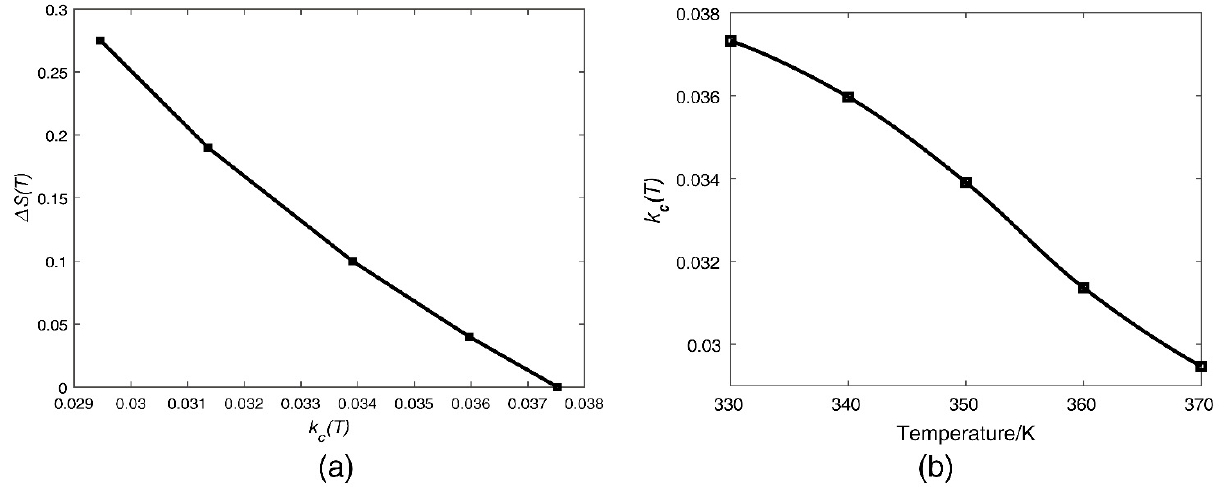
Figure 3. ( a ) The normalized drift of the parametric sensitivity in AR as with variation of coupling stiffness. Temperature ranges from 330 K to 370 K (these k c ( T ) data are extracted from simulation); ( b ) the coupling stiffness k c versus temperature T